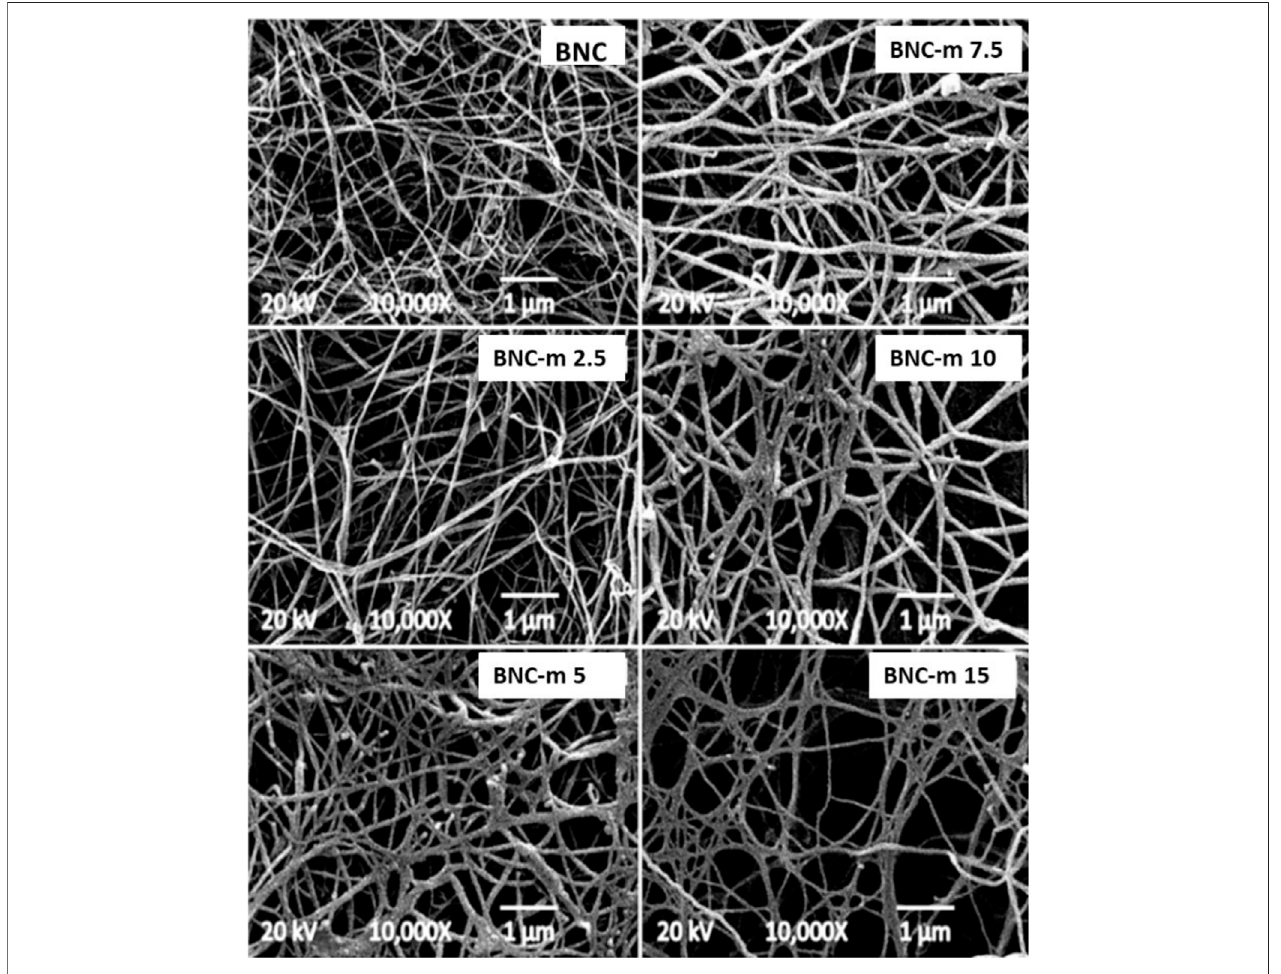
FIGURE 6 | SEM micrographs at 10000X.